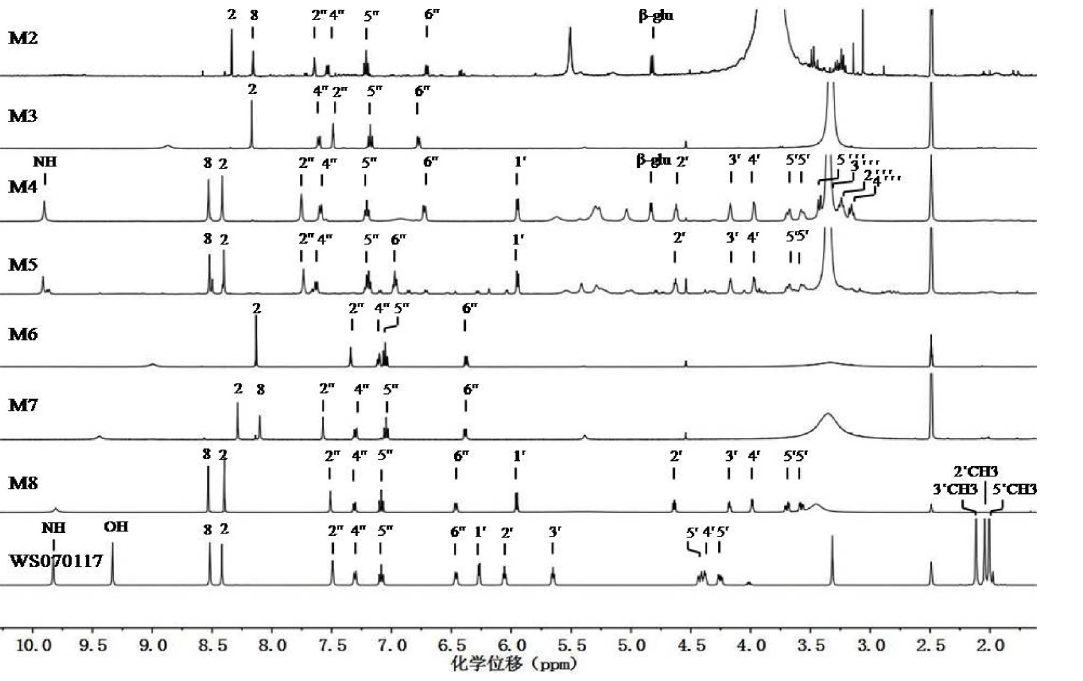
Fig 3. The stack of 1 H NMR spectra of WS010117 and its seven metabolites (in DMSO-d 6 ).